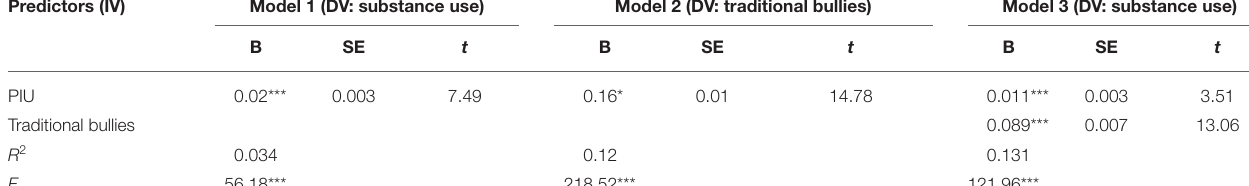
TABLE 2 | Regression model summary of the mediating effect of bullying/victimisation (traditional and cyber) on the relationship between PIU and substance abuse (Model 4) ( N = 1,613). Predictors (IV) Model 1 (DV: substance